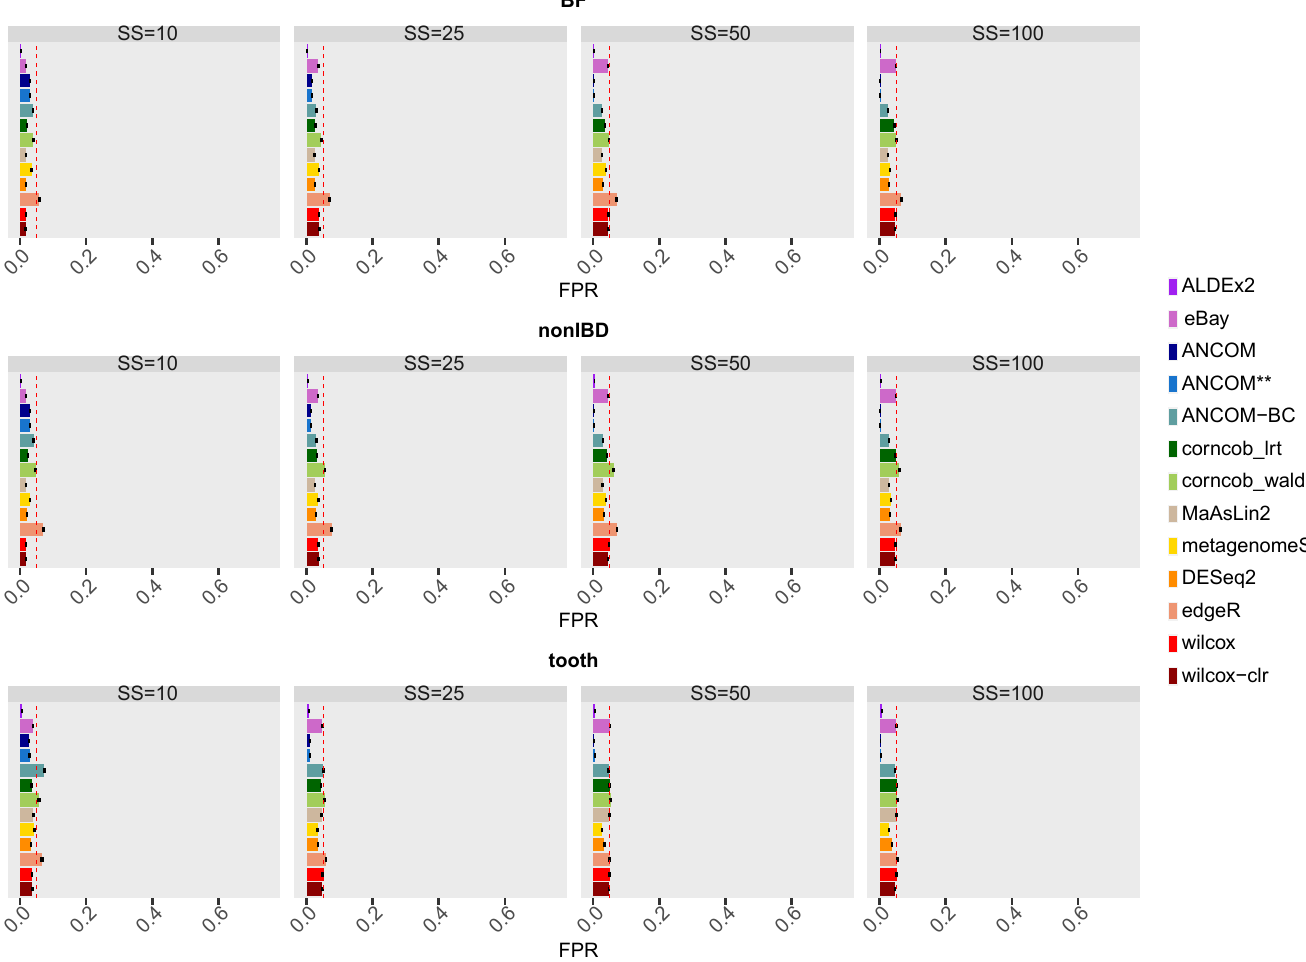
Fig 3. False Positive Rate (FPR) of each differential abundance method for each dataset considered in the comparison in the scenario without simulated DA features. In each set of boxes corresponding to the dataset, tools are on rows, while different sample size (SS) values are on columns. The FPR values are averaged over the 50 simulations and the bars show the standard error. The ANCOM �� label refers to the method run without performing the underlying FDR adjustment.